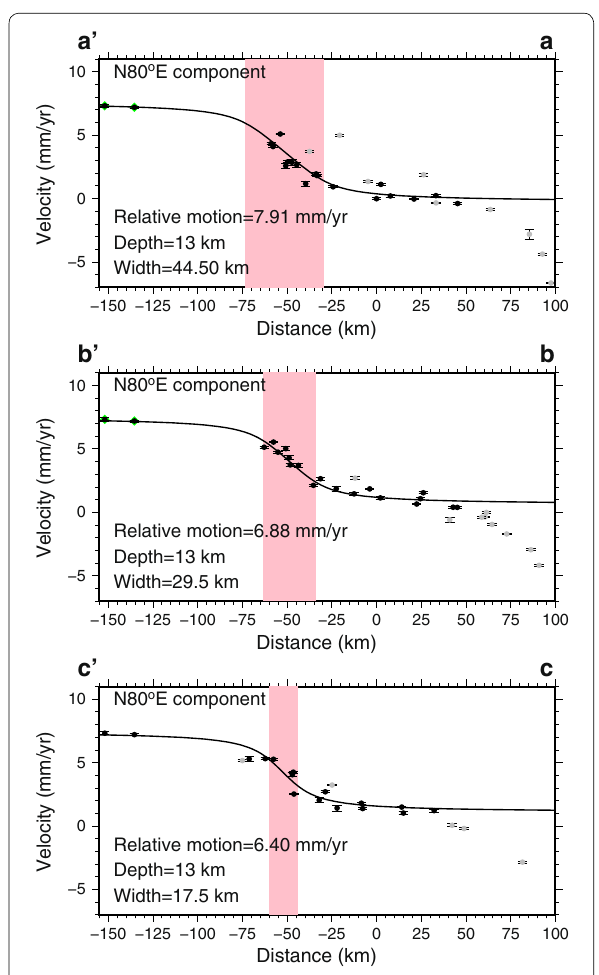
Fig. 2 Velocity profiles on the N80° E component across the SSZ. Profiles across Eastern ( a ), Central ( b ) and Western ( c ) Tottori are shown. Black dots denote velocities used for the grid search analysis. Gray dots represent velocities which were not used for the analysis, including outliers. Green diamonds indicate constraints taken from different profiles. Black curve denotes velocities calculated from elastic dislocation models that minimizes the sum of squared residuals. Pink area represents the best estimates of the location and width of the ductile